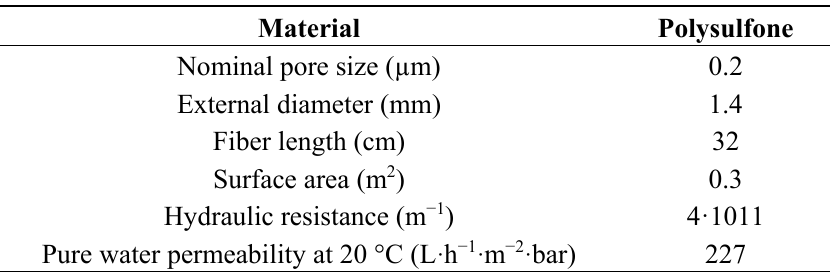
Table 1. Membrane